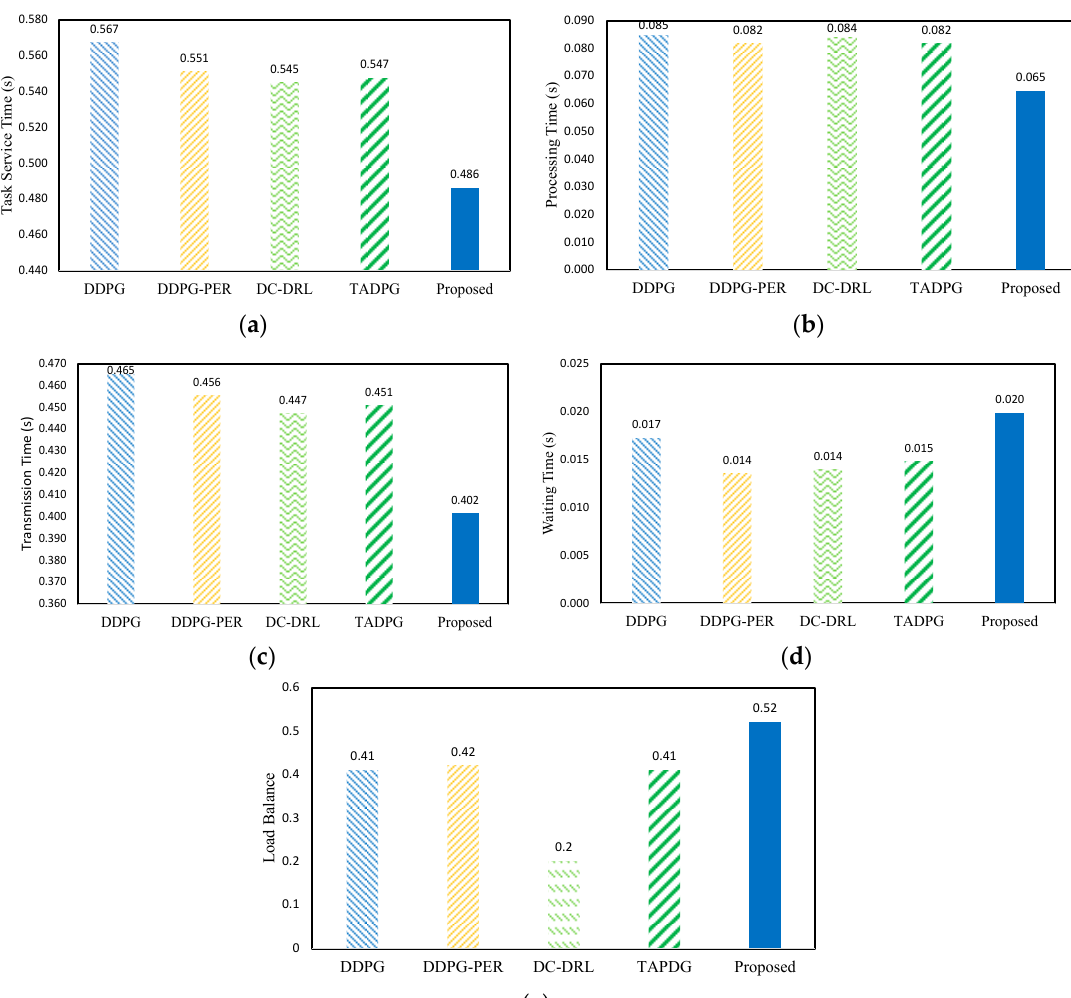
Figure 8. QoE comparison. ( a ) Task service time; ( b ) task processing time; ( c ) task transmission time; ( d ) task waiting time; ( e ) load balance.